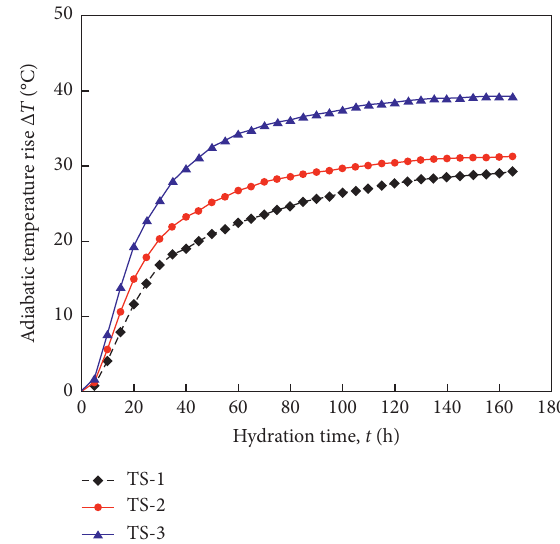
Figure 2: Adiabatic temperature rise curve of